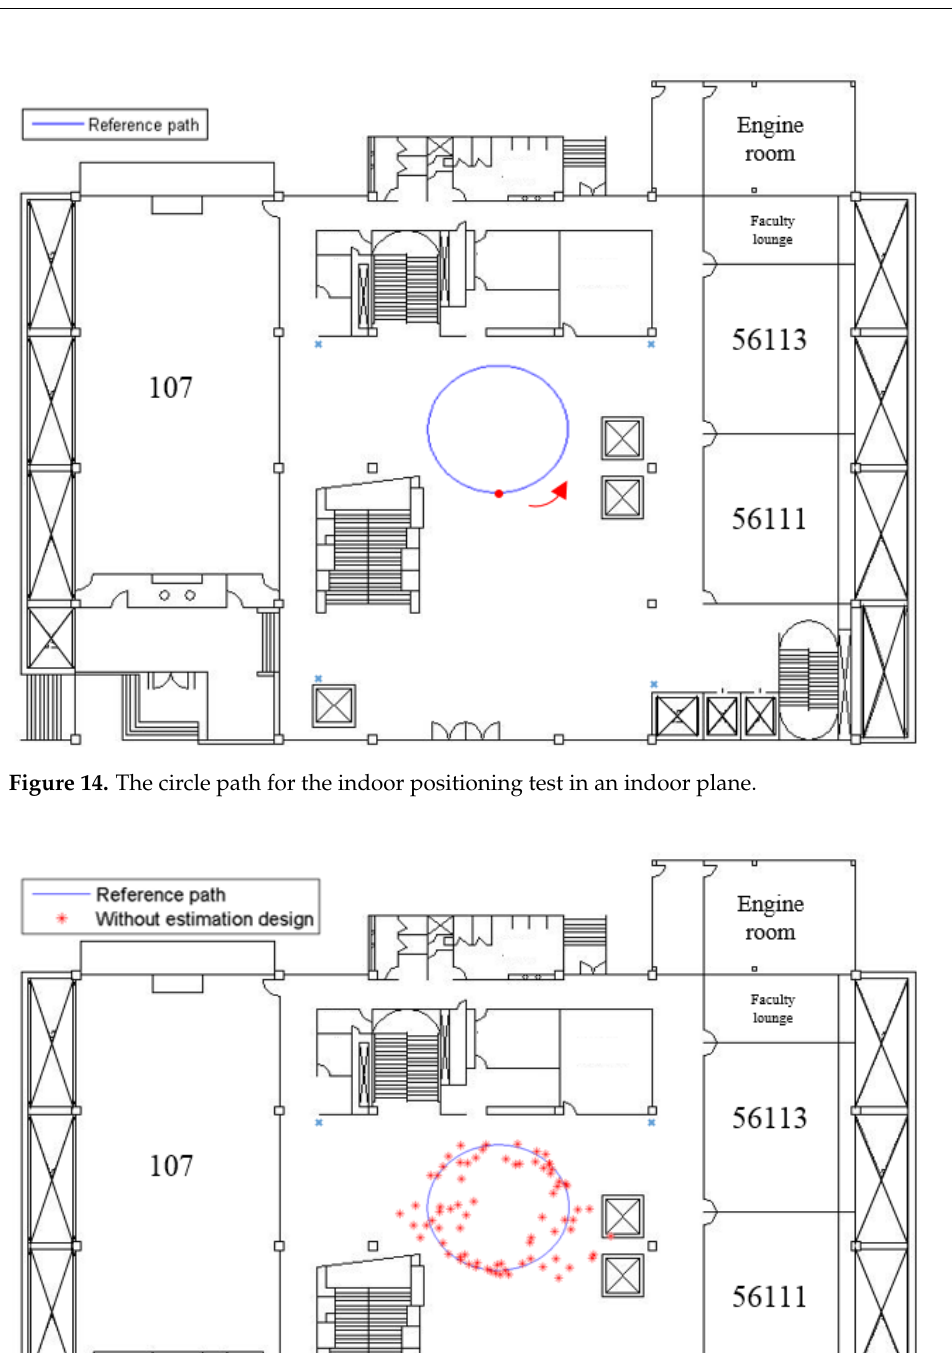
Figure 15. The indoor positioning result without any estimation design.